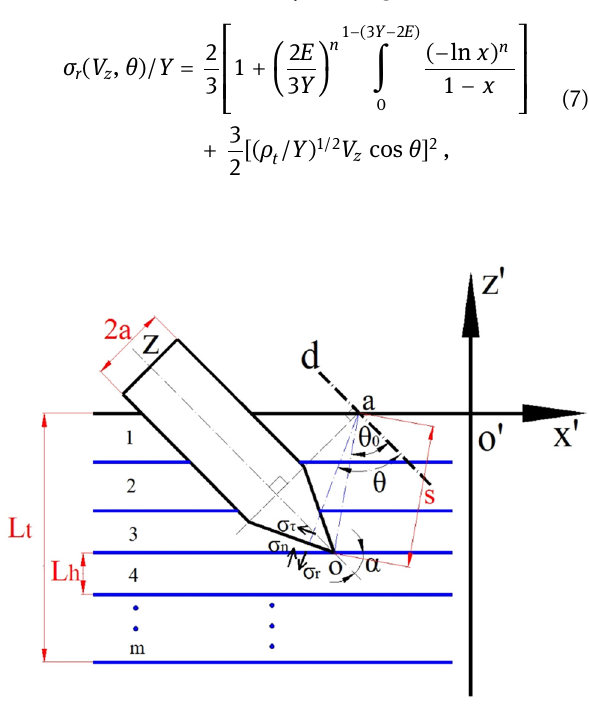
Figure 1: Penetration diagram of hybrid fi ber